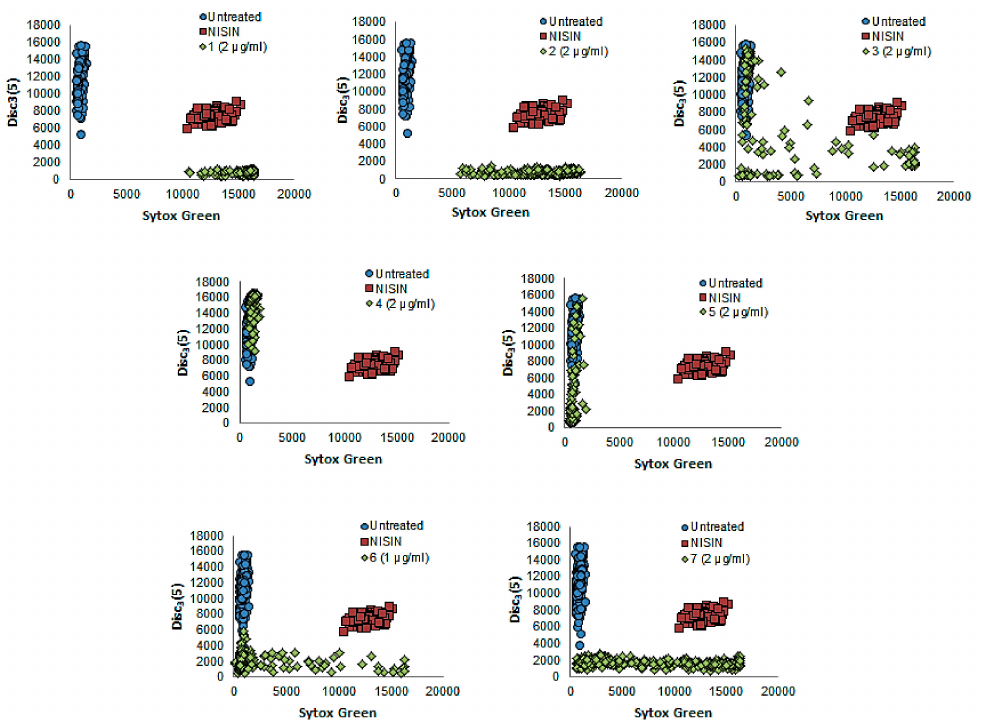
Figure 7. Depolarization and pore formation of B. subtilis WT168 induced by Ag(I)-NHC-containing dendritic systems. Bacteria treatment with: (blue) distillated sterile water; (red) Nissin as the pore formation standard; (green) dendritic